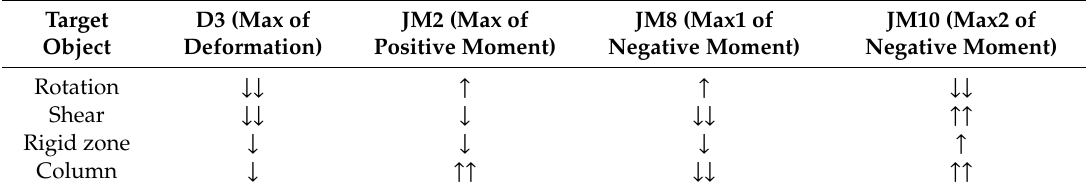
Table 8. Summary of the tendency and sensitive level of di ff erent